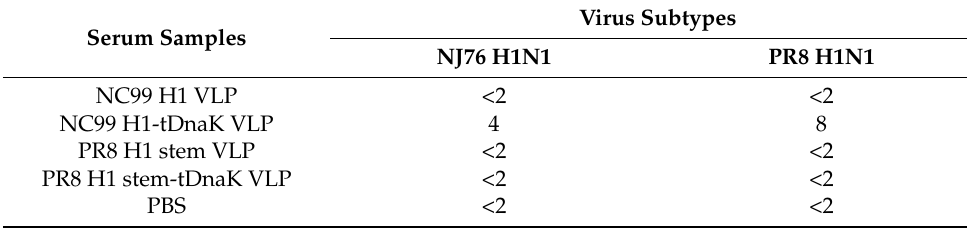
Table 2. Virus neutralization titers determination. The highest dilution factors of the diluted heat- inactivated serum that were able to neutralize 150 × TCID 50 of NJ76 or PR8 H1N1 virus are shown in the